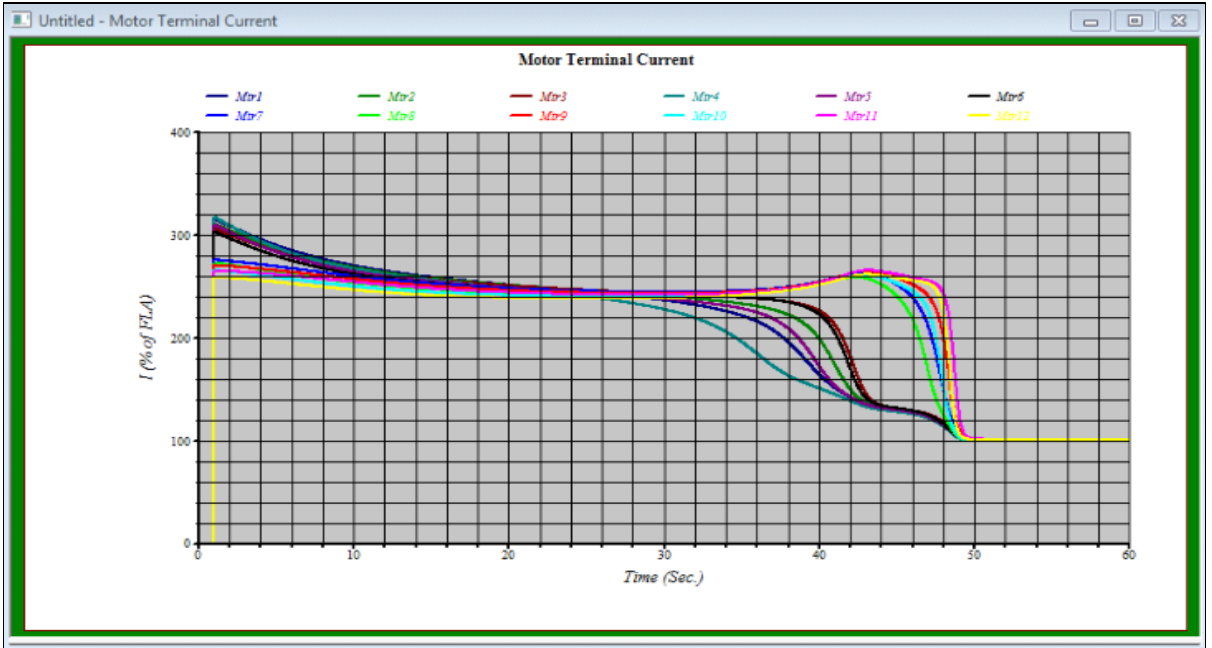
Figure 8: The starting current of the motors as a function of time after the insertion of the capacitor banks. Source: Authors, (2020).